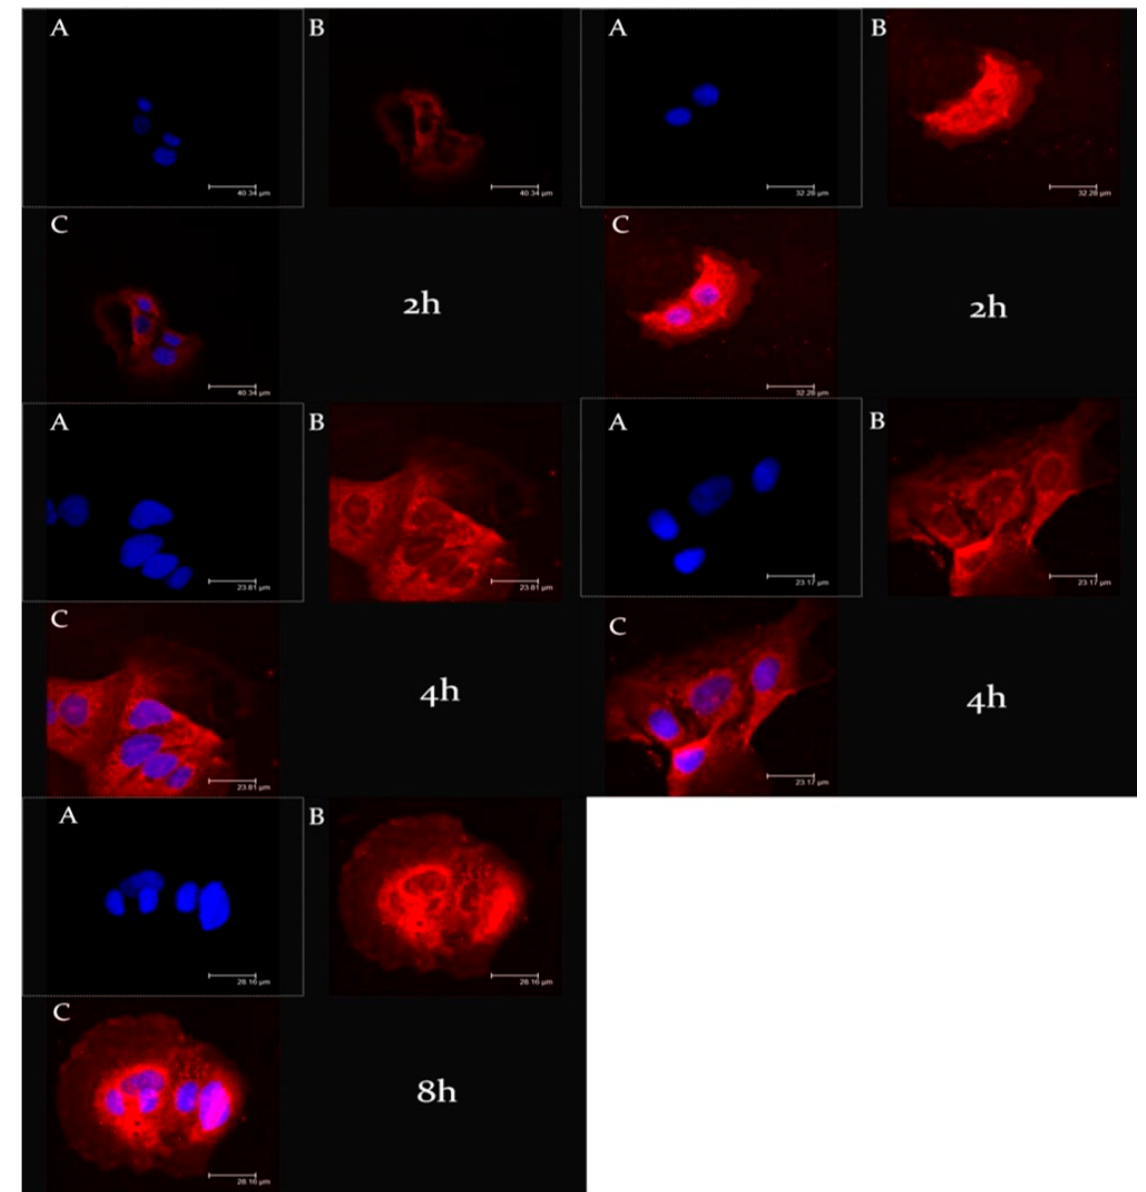
Figure 6. CLSM micrographs of CaCo-2 human colorectal adenocarcinoma cells treated with rhodaminated formulation (A) (left) and (B) (right) as a function of incubation time. ( A ): Hoechst filter; ( B ): TRITC filter; and ( C ): Overlay.